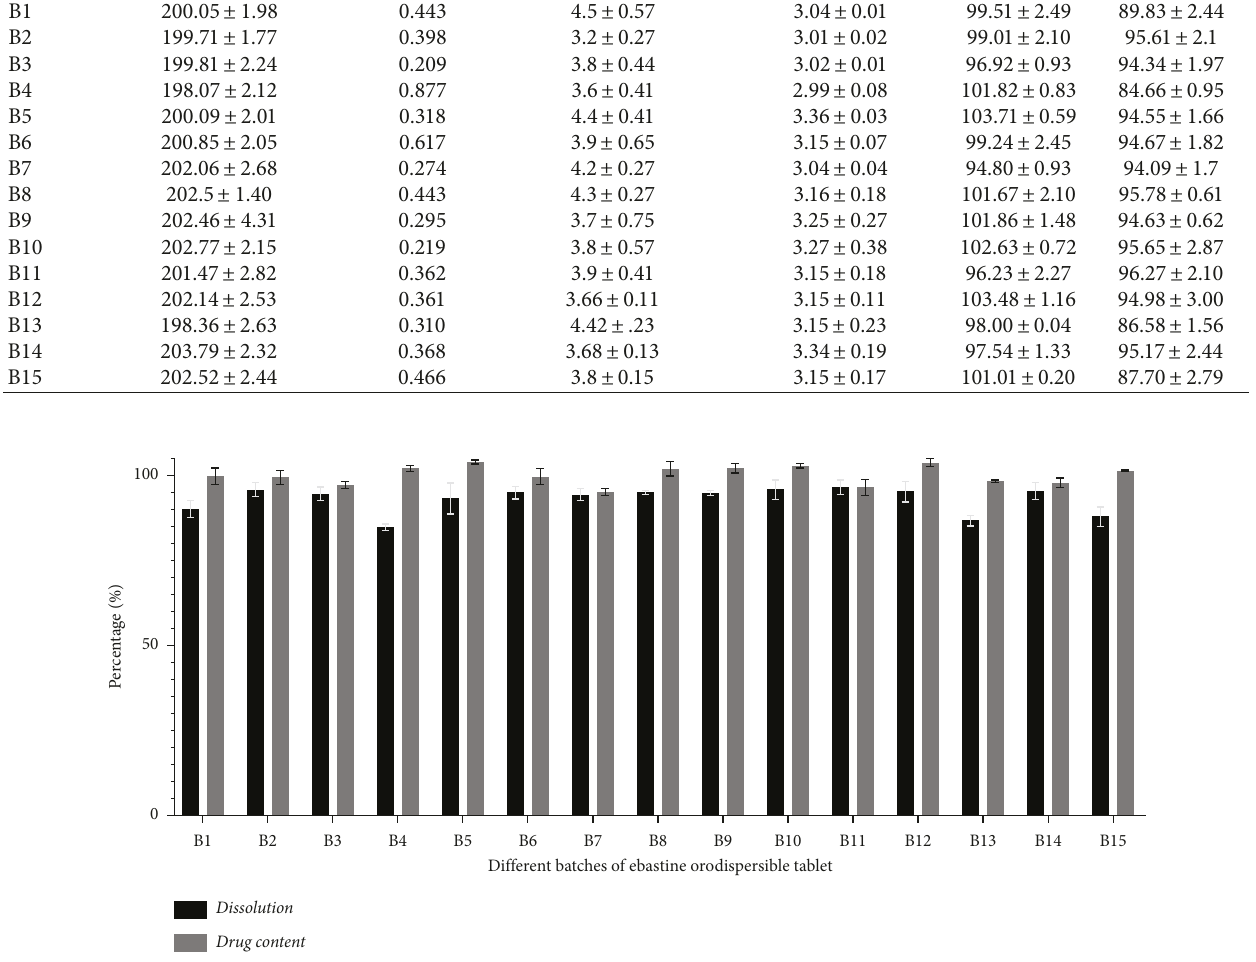
Figure 2: Bar diagram showing drug content and dissolution behavior of different batches.